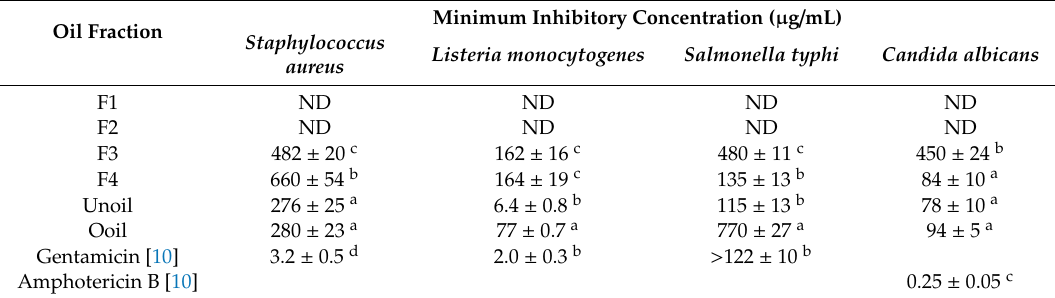
Table 6. Minimum inhibitory concentration ( μ g/mL) of each fraction.